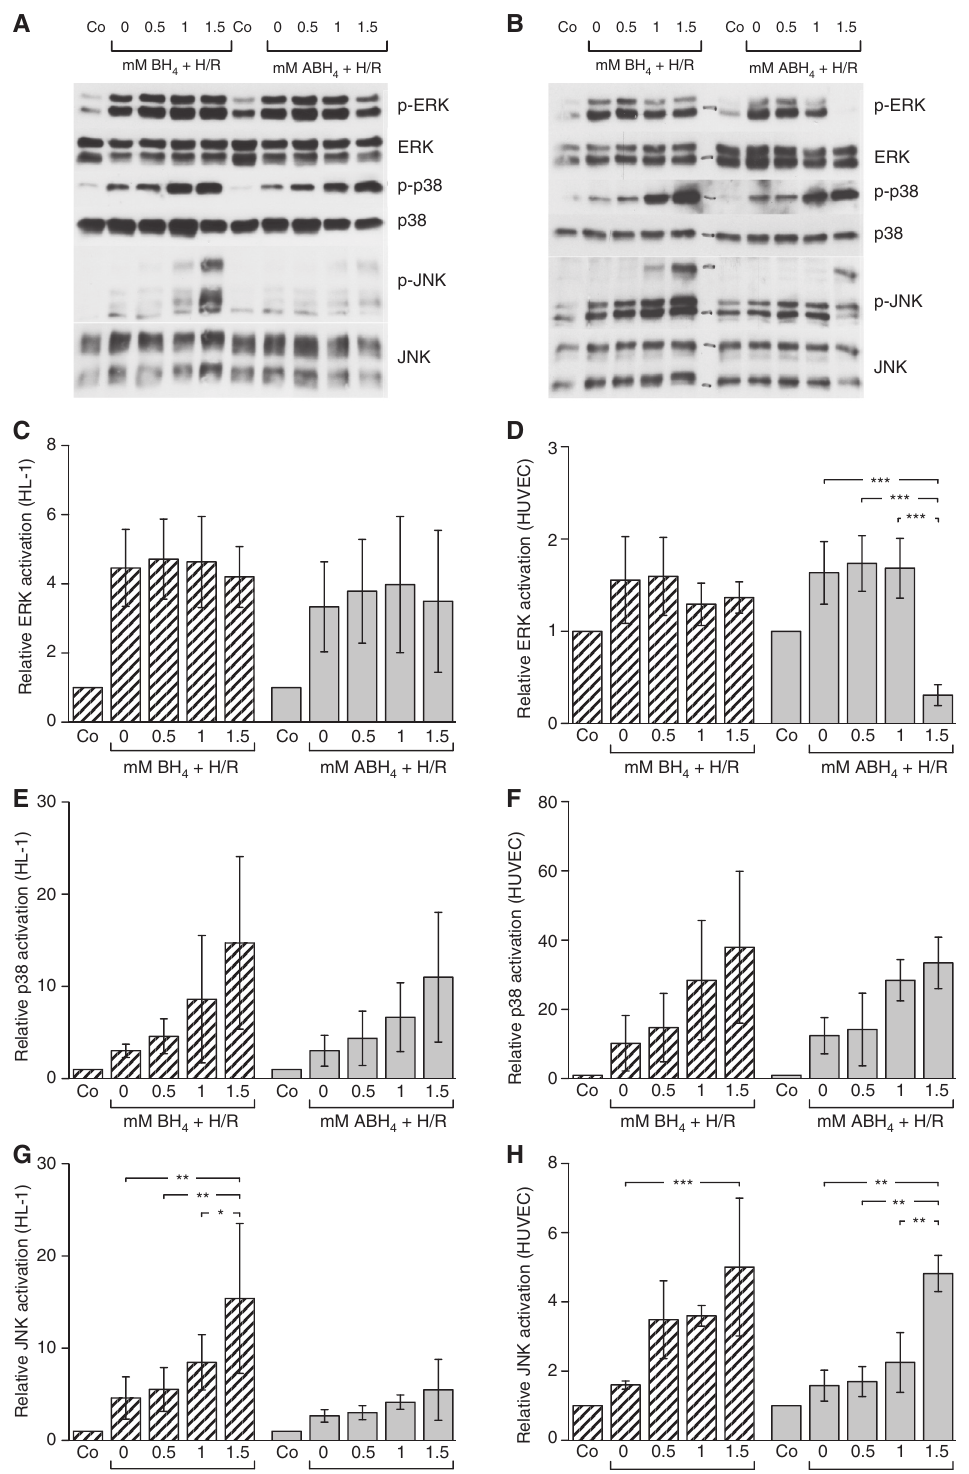
and ABH in HL-1 cells and HUVECs. Cells were pretreated with 0.5, 1, or 1.5 mM Figure 2 Modulation of H/R-induced MAPK activation by BH 4 4 of BH or ABH for 5 h or left untreated (0 mM BH /ABH ) before exposing them to 1 h of hypoxia followed by 10 min of reoxygenation. (A and B) 4 4 4 4 Representative immunoblots for HL-1 cells (A) and HUVECs (B). (C–H) Summary bar graphs of BH and ABH effects on ERK, p38, and JNK signal- 4 4 ing in HL-1 cells (C, E, G) and HUVECs (D, F, H) during H/R. Relative activation levels were calculated by normalizing phospho-MAPK signals to total MAPK levels; untreated normoxic controls (Co) were set to 1.0. Data are expressed as mean ± SD (n = 3, *p < 0.05, **p < 0.01, ***p <